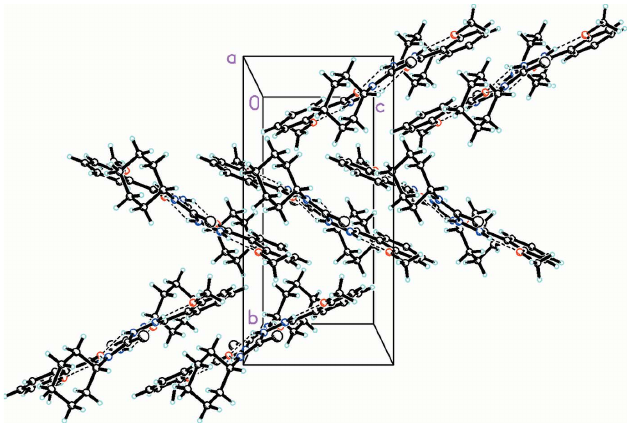
Figure 3 A view along the a axis of the crystal packing of the title compound,